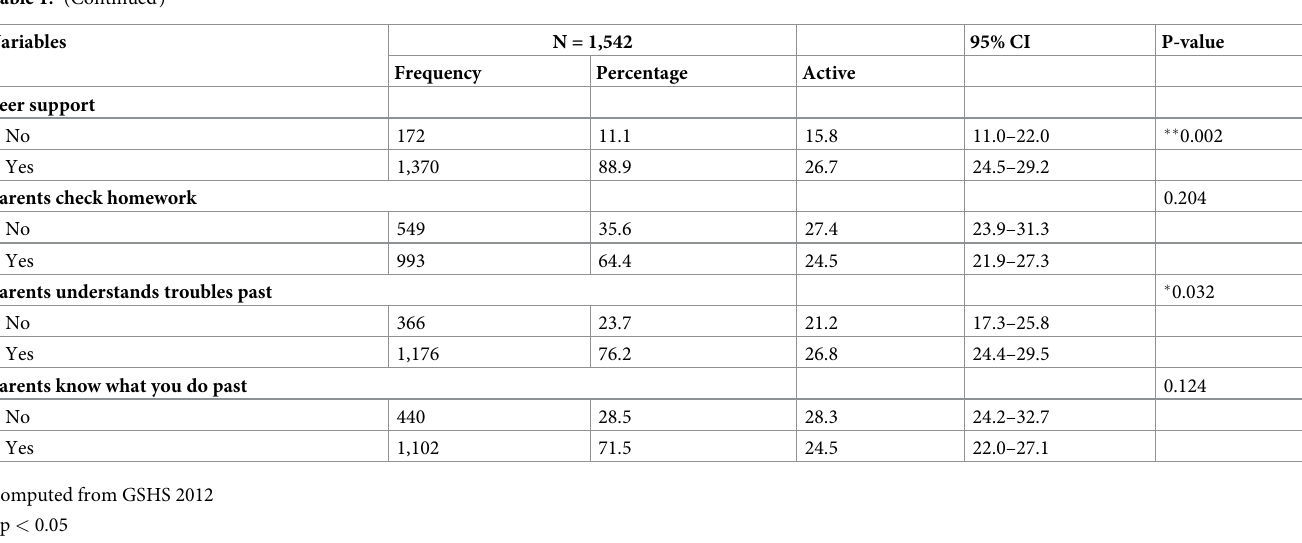
Details of the demographic characteristics of the participants in this study are presented in Table 1. In terms of age, the students aged 18 and above had the highest proportion of suffi- cient physically active, compared to those aged 12–17. In relation to grade, the students in SHS4 had the highest proportion of sufficient physical activity. It was also shown that students who did not experience hunger—a measure of socio-economic status—had higher proportion of sufficient physical activity compared, to those who experienced hunger. In relation to vege- table and fruit consumption, 26.1% of those who indicated they do not eat fruits and vegetables were physically active. In terms of parental factors, 26.7% of the students who indicated their parents understand their troubles were sufficiently physically active. The chi-square analysis revealed that sex ( χ 2 = 12.3 p < 0.001), grade ( χ 2 = 14.1, p < 0.01), socio-economic status ( χ 2